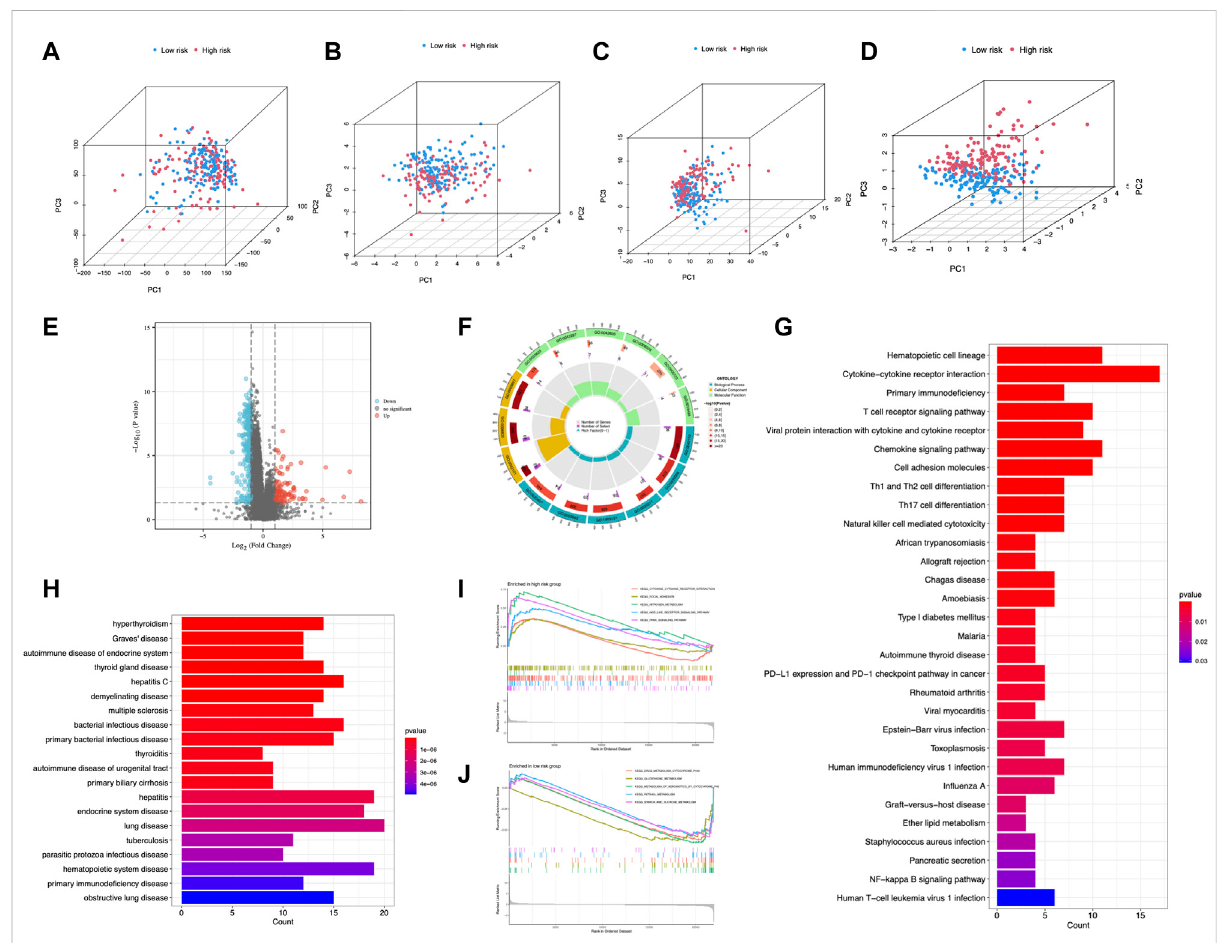
FIGURE 8 PCA and enrichment analysis in different risk groups. PCA analysis of risk groups based on (A) the expression of all examined genes, (B) cuproptosis-associated genes, (C) cuproptosis-associated lncRNAs, and (D) the 6 lncRNAs of the risk model. (E) DEGs between risk groups. GO (F) , KEGG (G) , and DO (H) enrichment of DEGs. GSEA of the high-risk group (I) and low-risk group (J)